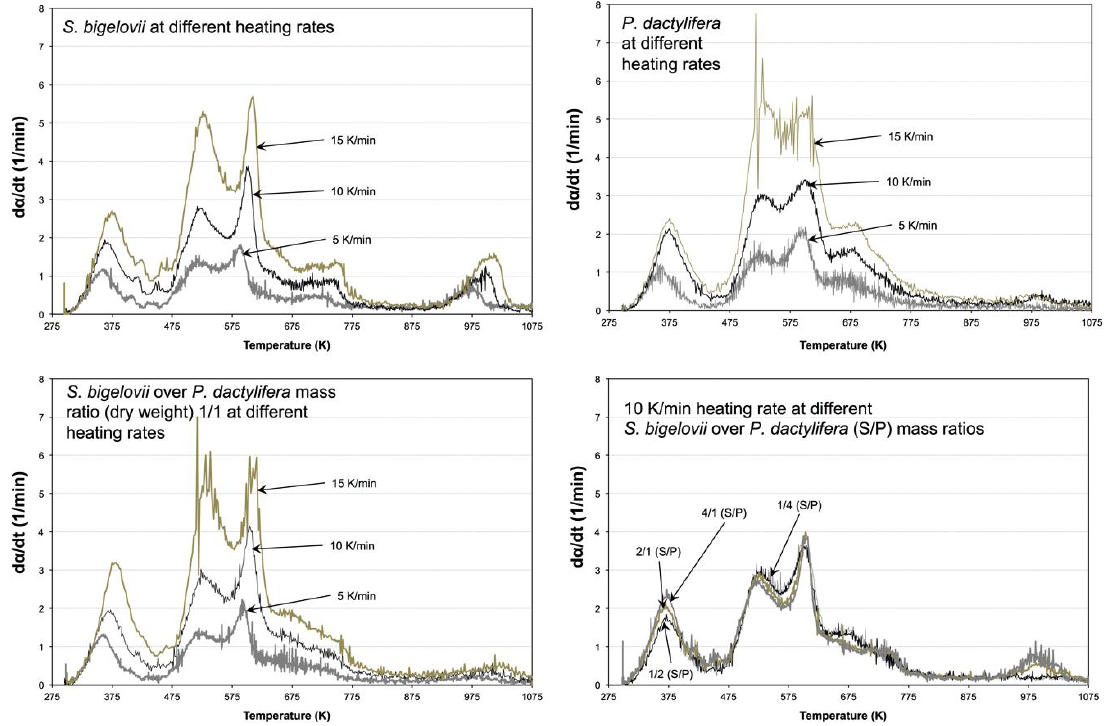
Figure 2. Decomposition rates ( d α / dt ) of S. bigelovii , P. dactylifera , and mixtures of them, at different heating rates (K/min) showing peak temperatures.